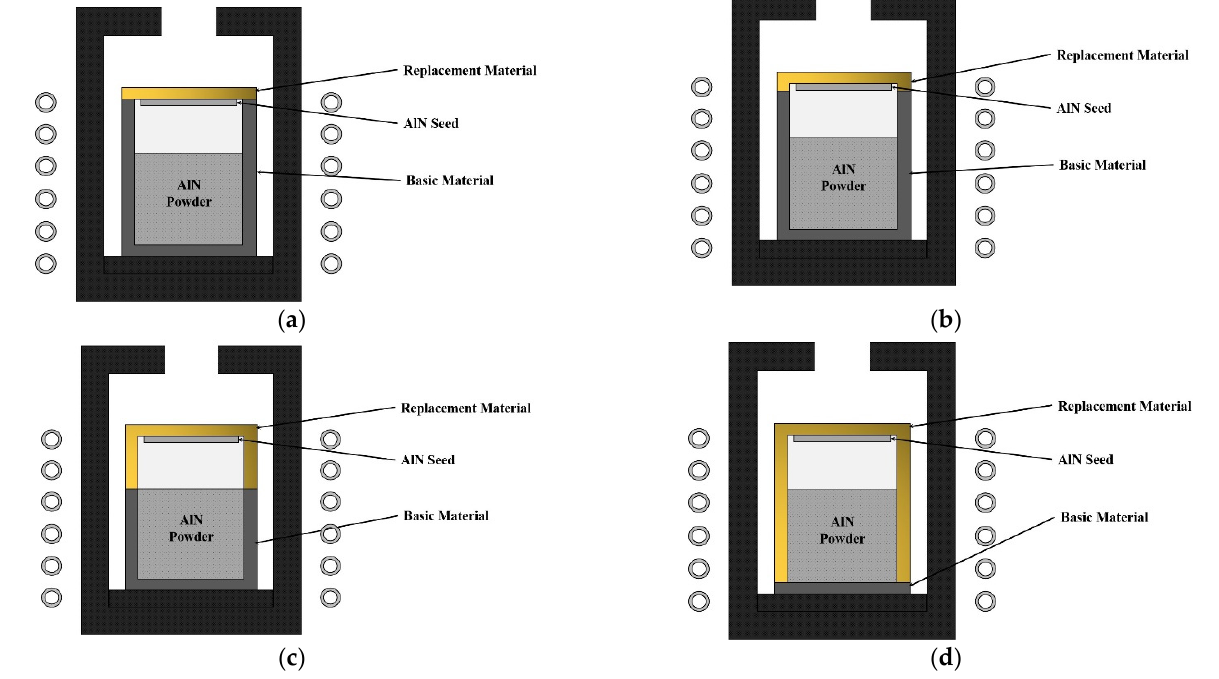
Figure 5. Schematic diagrams of the composite crucibles ( a ) Composite crucible A, ( b ) Composite crucible B, ( c ) Composite crucible C, ( d ) Composite crucible D.